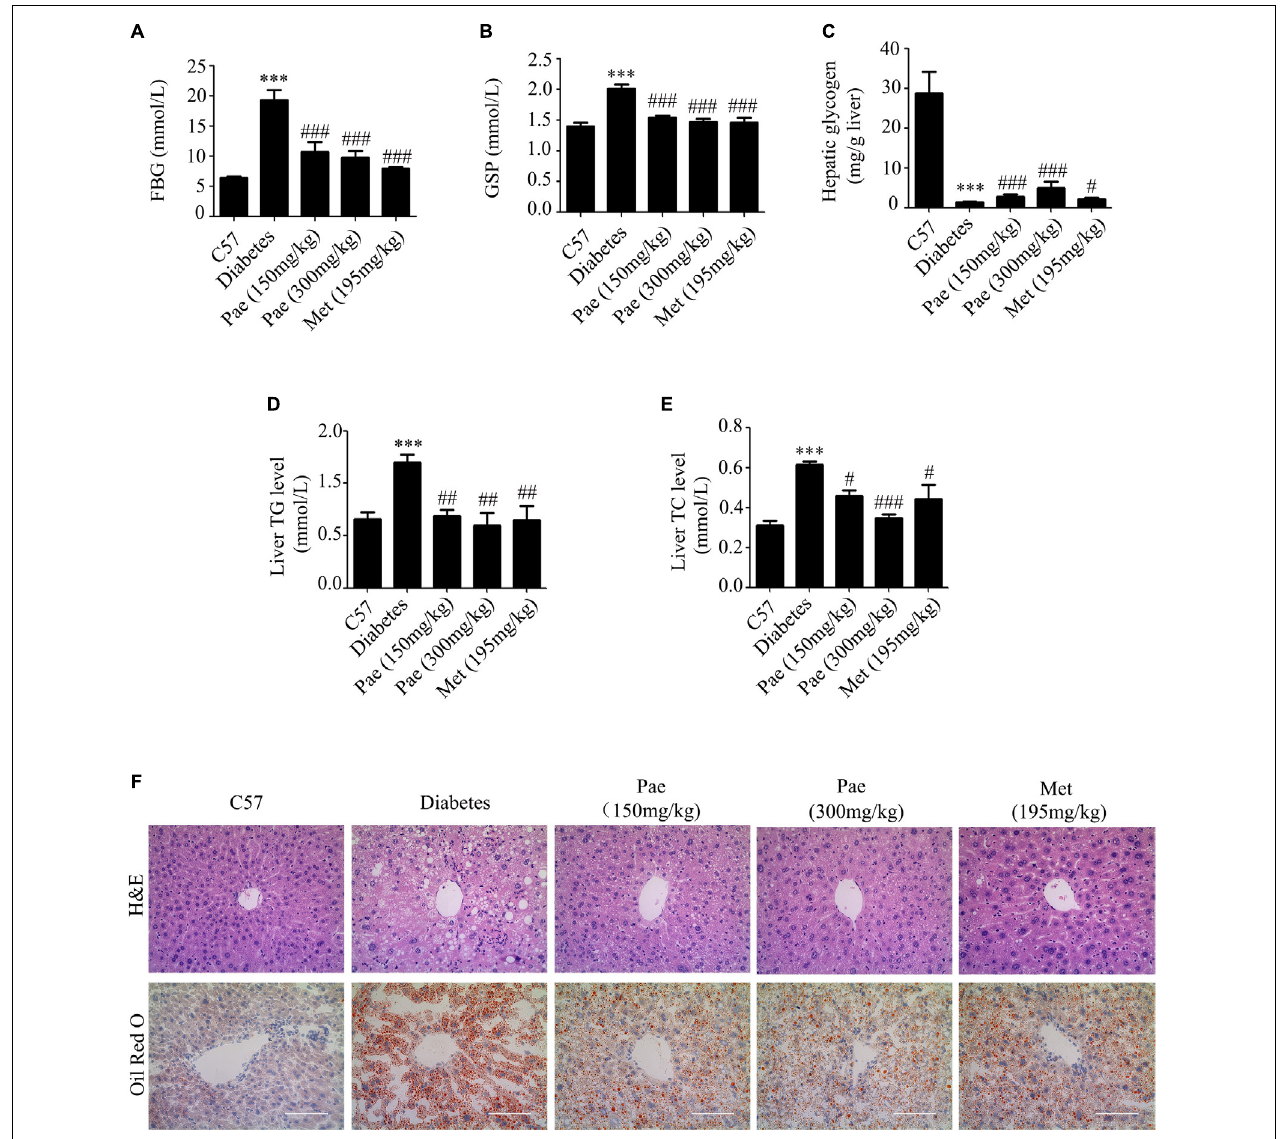
FIGURE 1 | Paeonol ameliorated glucose and lipid metabolism and protected the liver in diabetic mice. (A,B) Measurements of FBG and GSP ( n = 6-8). (C–E) Measurements of glycogen, TG and TC in diabetic livers ( n = 6–8). (F) Histochemical analysis of liver tissues in diabetic mice, assessed by H&E and Oil Red O staining ( × 400 magnification). ∗∗∗ p < 0.001 vs. C57; # p < 0.05, ## p < 0.01, and ### p < 0.001 vs.